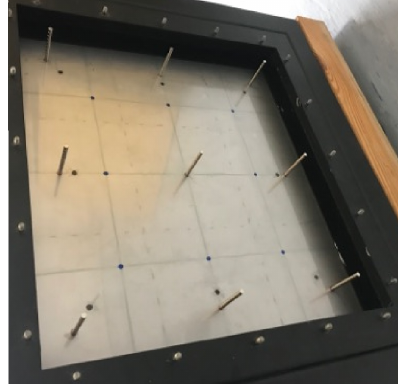
Figure 9. Neodymium magnets, mounted on the incident plate.